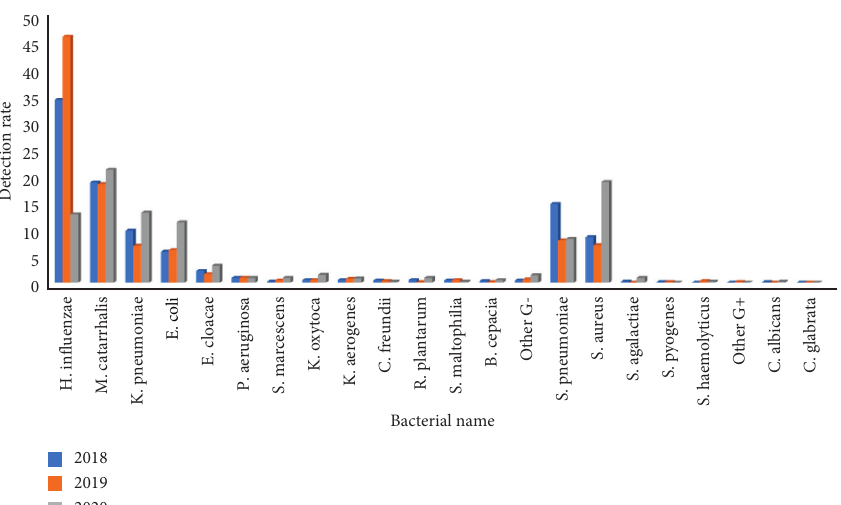
Figure 8: Detection rate of pathogens in lower respiratory tract in the second quarter before and after the pandemic situation of COVID-19